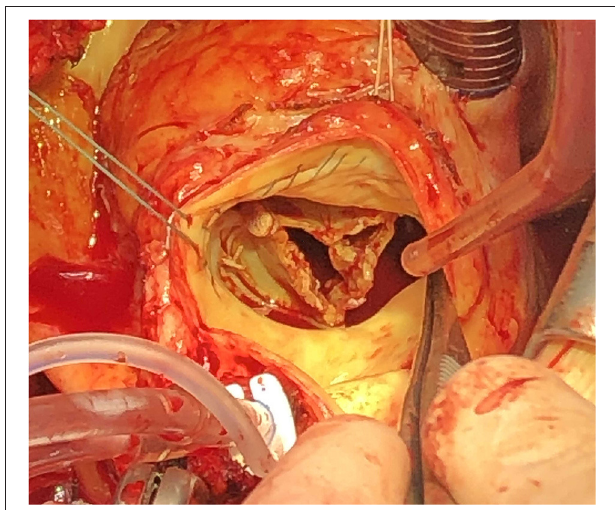
FIGURE 4 | Intraoperative finding of the vegetations at a bioprosthesis.